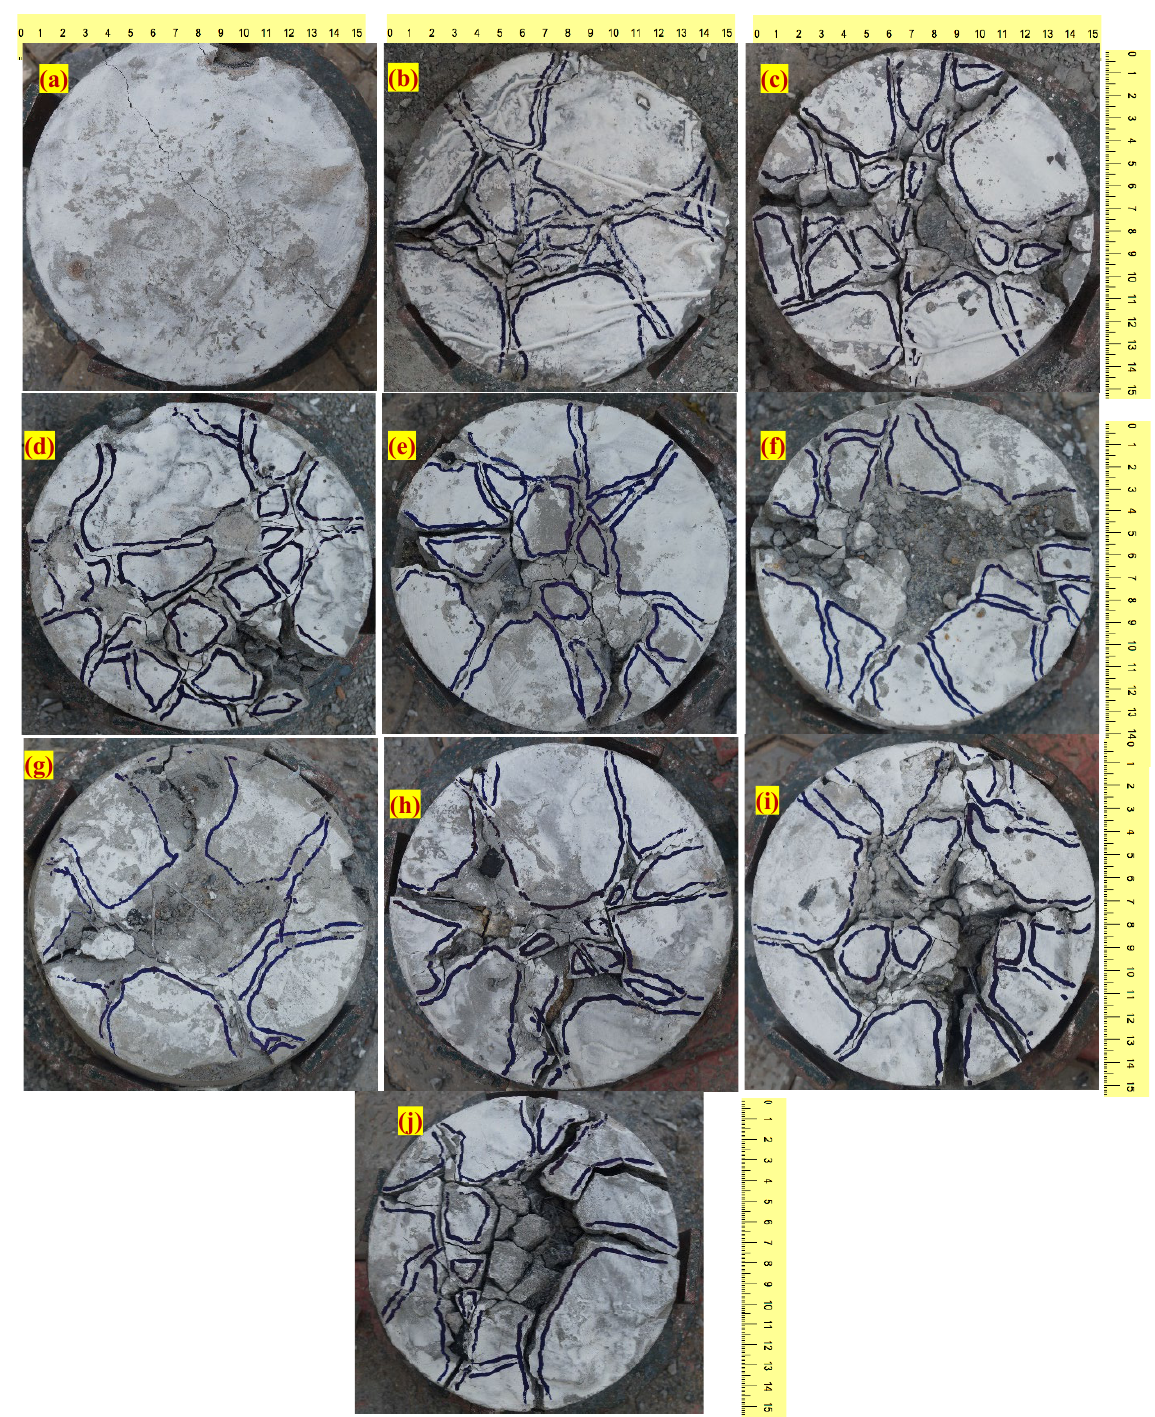
Figure 9. Failure pattern of specimens under impact loading. ( a ) R0, ( b ) R5, ( c ) R10, ( d ) R15, ( e ) R20,